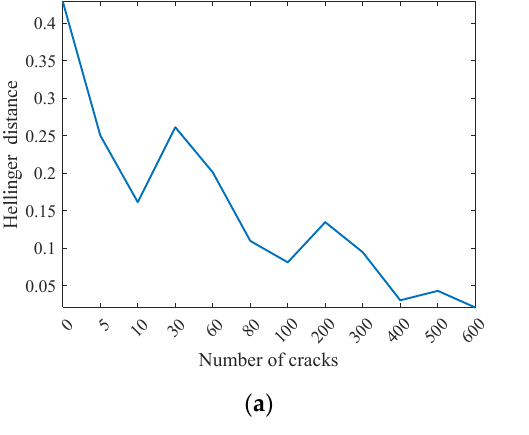
Figure 12. Probability distribution updating of initial crack length with the increasing number of ( a ) considered cracks and ( b ) adopted observations.